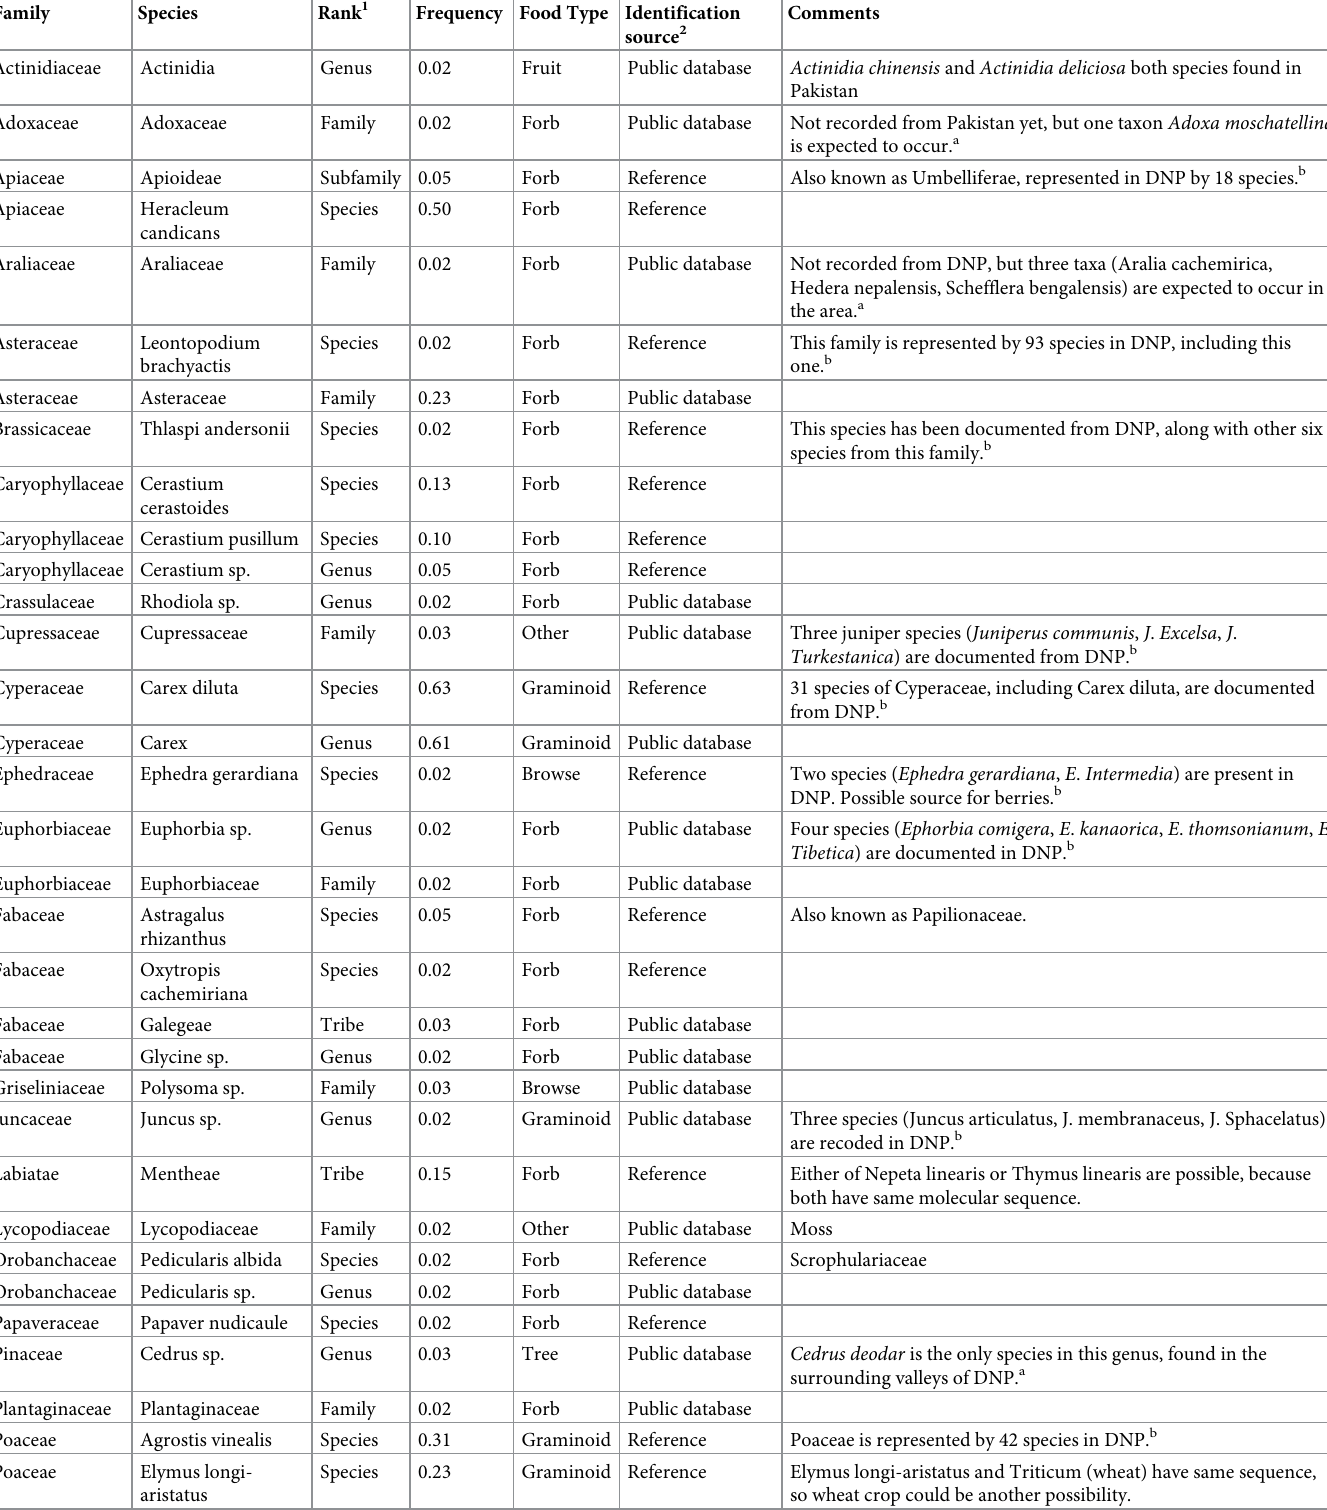
Table 2. A complete list of plant species identified by the trn L approach in the diet of brown bears in Deosai National Park,